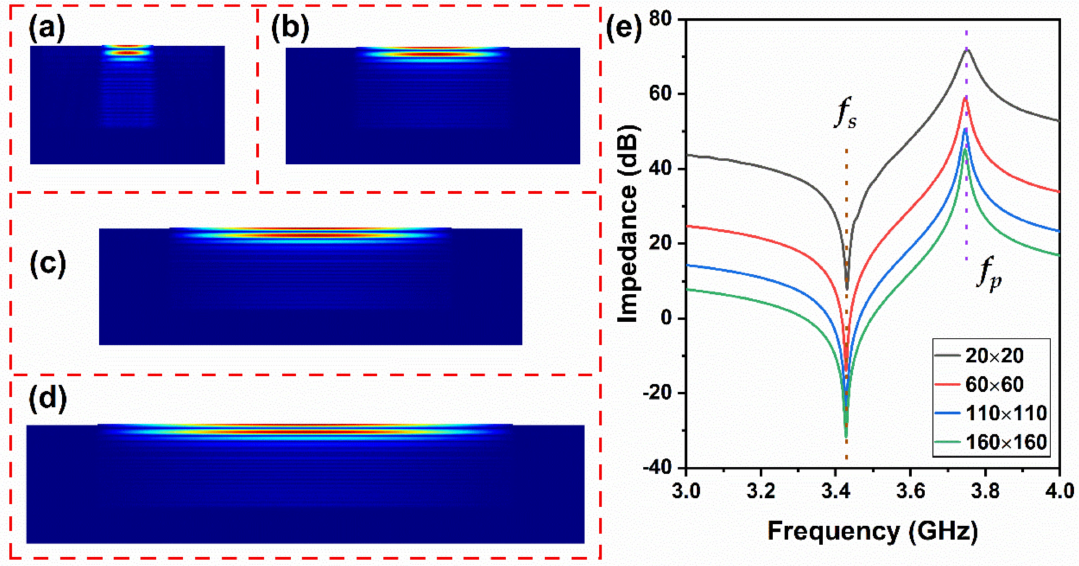
Figure 5. Mode shapes at resonant frequencies with different sizes: ( a ) 20 × 20 µ m 2 ; ( b ) 60 × 60 µ m 2 ; ( c ) 110 × 110 µ m 2 ; ( d ) 160 × 160 µ m 2 . ( e ) Simulated impedance curves of different